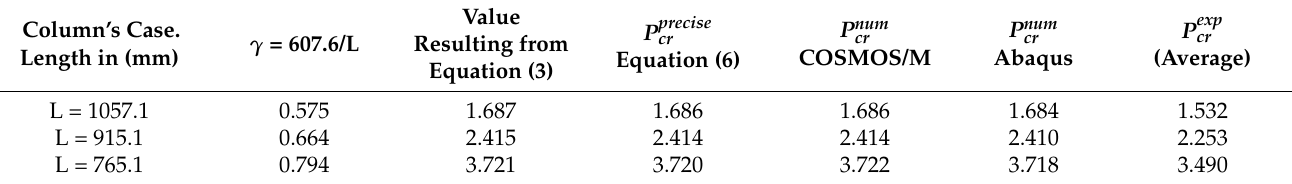
Table 2. Critical forces in